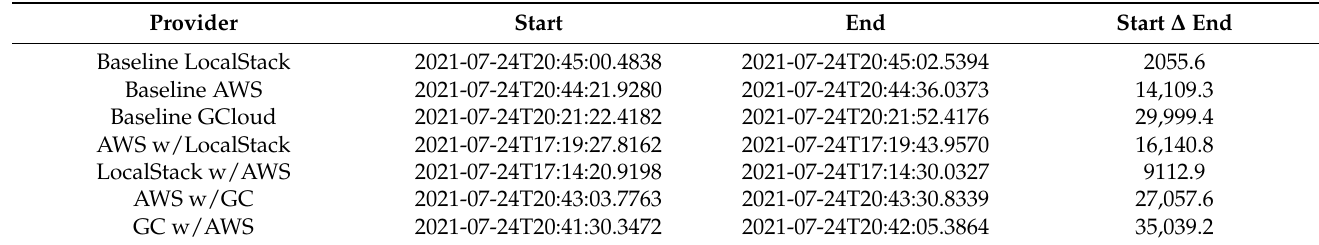
Table 1. Speed of upload using single and